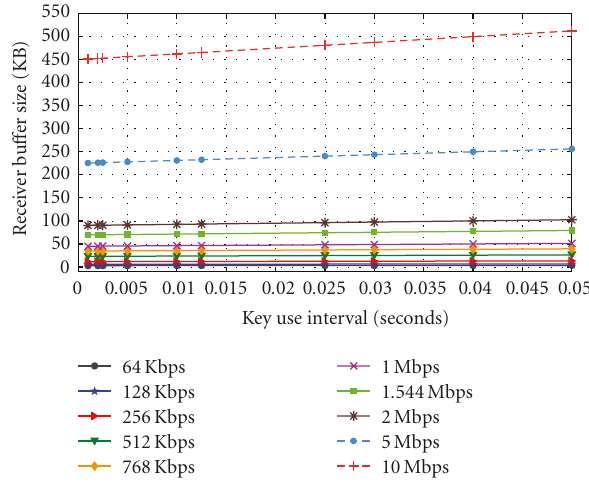
Figure 6: Receiver bu ff er size for varying network bandwidths and key use intervals.